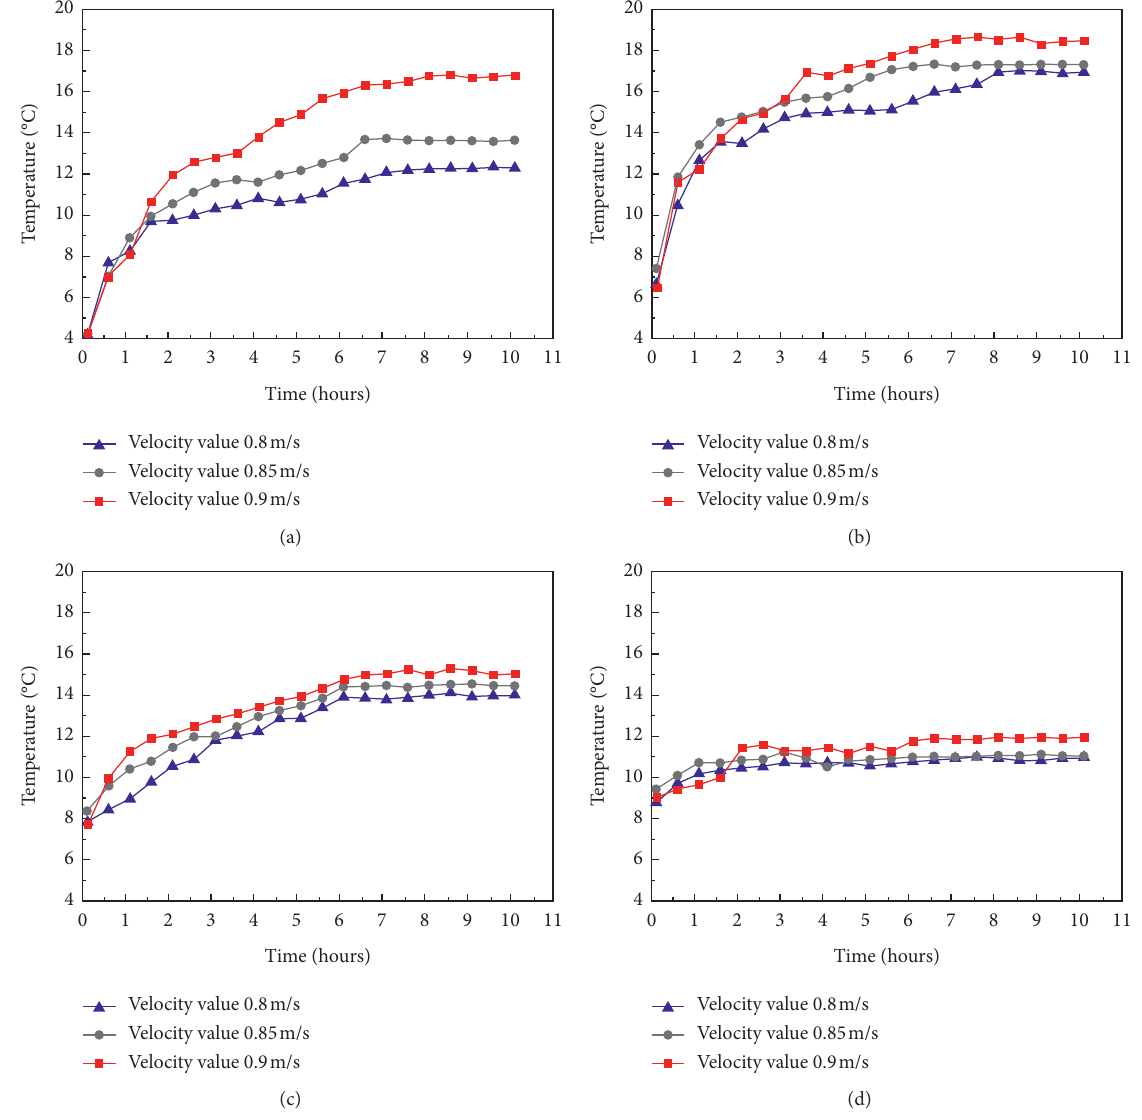
Figure 6: Temperature change curves of the measuring points of each layer: (a) the first layer; (b) the second layer; (c) the third layer; (d) the fourth layer. Table 5: Temperature rise value of the first layer under flow velocity